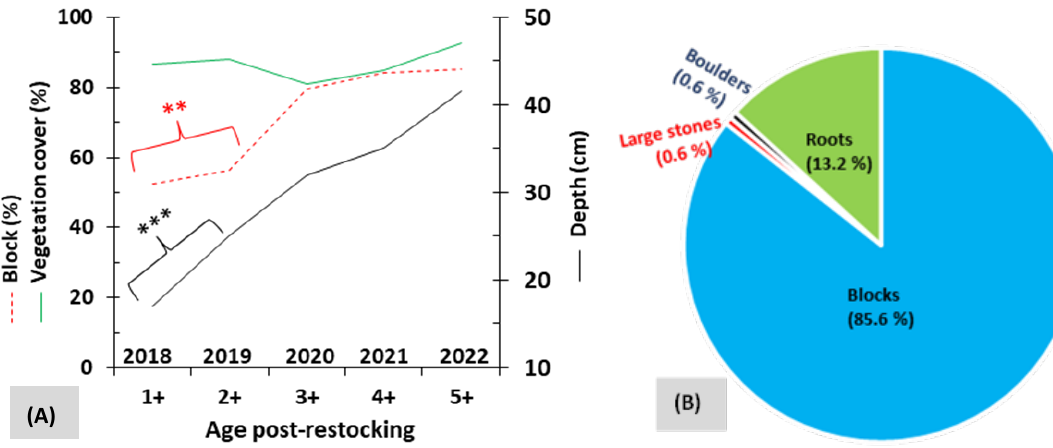
Figure 4. Mean evolution over time of the microhabitat characteristics used by the restocked eels ( A ). Utilisation of bottom substrate in eels 5 + ( B ) ( n = 159 during the 2022 detection session). Particle sizes (in cm, the diameter perpendicular to the longest axis) are: boulders (>102.4), blocks (26 – 102) and large stones (13 – 25) [37]. Roots are submerged roots of riparian trees . *** Kruskal – Wallis followe d by Dunn’s test: p < 0.00001 for water depth. ** Fisher’s exact test: p < 0.001 for block use).